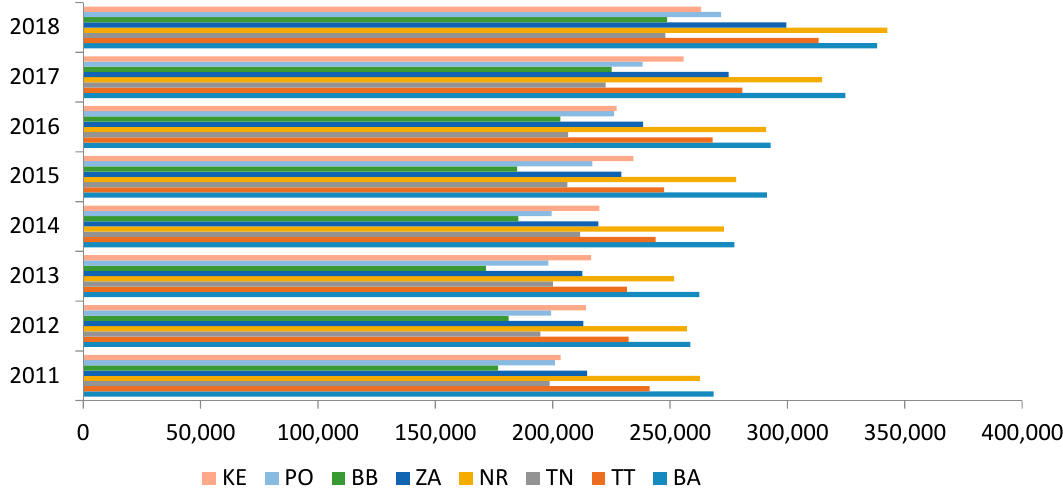
Figure 2. Development of municipal waste production in the regions of Slovakia. Source: Based on of data collected by Statistical Office of Slovak Republic [29]. Note: KE—Košice region, PO—Prešov region, BB—Banská Bystrica region, ZA—Žilina region, NR—Nitra region, TN—Tren č ín region, TT— Trnava region, BA—Bratislava region.